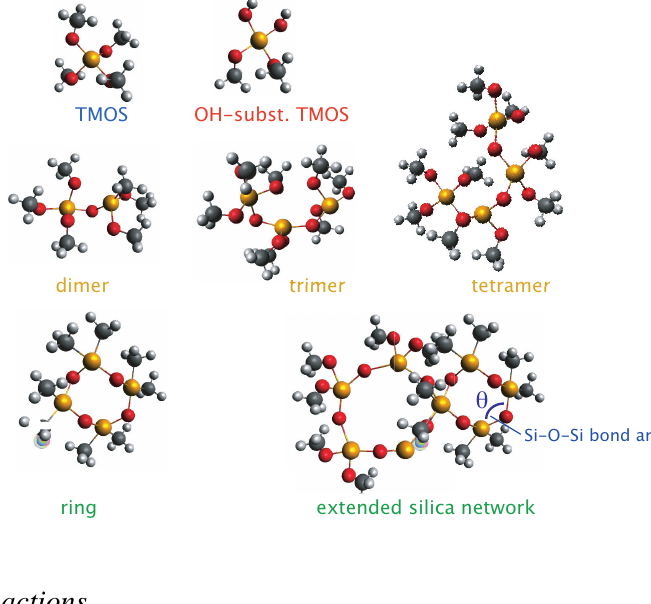
Figure 2. Different silica intermediates participating in the sol-gel reaction, i.e. , monomers (top), linear chains (middle), and cyclic forms or n -membered rings (bottom). Atom labels: Si (yellow), O (red), C (grey), and H (white). The inter-tetrahedral bond angle θ is also